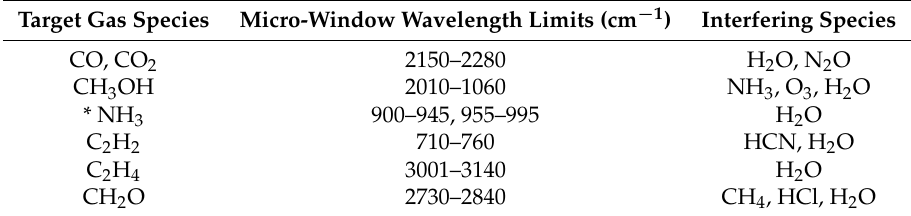
Table 1. Spectral Micro-windows limits used for the Multiple Atmospheric Layer Transmission (MALT) analysis of the Open Path-Fourier Transform Infrared (OP-FTIR)